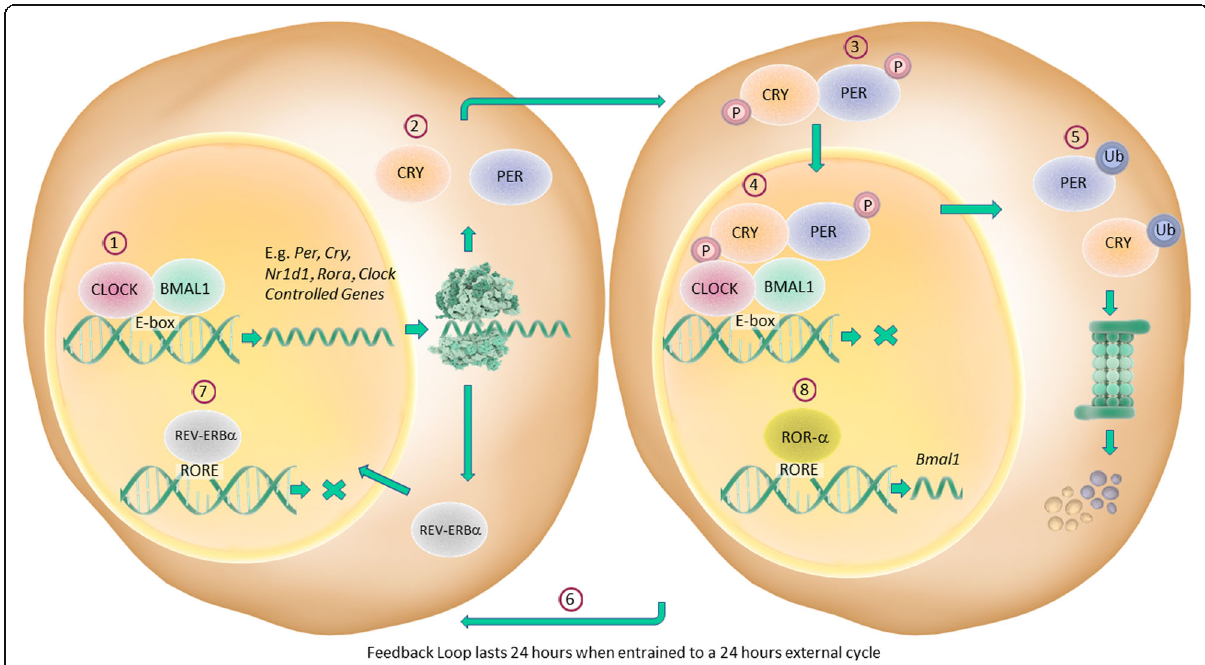
Fig. 2 Scheme representing the same mammalian cell, e.g. SCN cell, showing the molecular circadian clock sequence of events that under normal entrainment conditions in nature, lasts 24 h. ① CLOCK and BMAL1 proteins form a heterodimer which activates the transcription of genes encoding other core components of the loop: e.g. Cryptochrome ( Cry1 and Cry2 ), Period ( Per1 and Per2 ), Nr1d1 (REV-ERB- α protein) or Ror- α . CLOCK and BMAL1 also regulate the transcription of the so-called clock controlled genes. Among these genes there are key factors in processes intimately related to immune response. ② Cry and Per mRNAs are translated into CRY and PER proteins with levels increasing during the night and form a heterodimer. ③ CK1 δ and CK1 ε phosphorilate CRY and PER proteins allowing their translocation into the nucleus. ④ In the nucleus, the CRY/PER heterodimer represses the BMAL1/CLOCK activity thereby inhibiting their own transcription. ⑤ CRY and PER proteins are ubiquinated leading to their degradation via the 26S proteosome. ⑥ CRY and PER levels decrease and with it their repression over BMAL1/CLOCK, allowing for a new cycle to start again and the completion of the 24-h feedback loop. BMAL1/CLOCK also regulate the expression of the nuclear receptors Nr1d1 ( ⑦ REV-ERB- α protein) and Ror- α ( ⑧ ROR- α protein) which will, in turn, repress or activate Bmal1